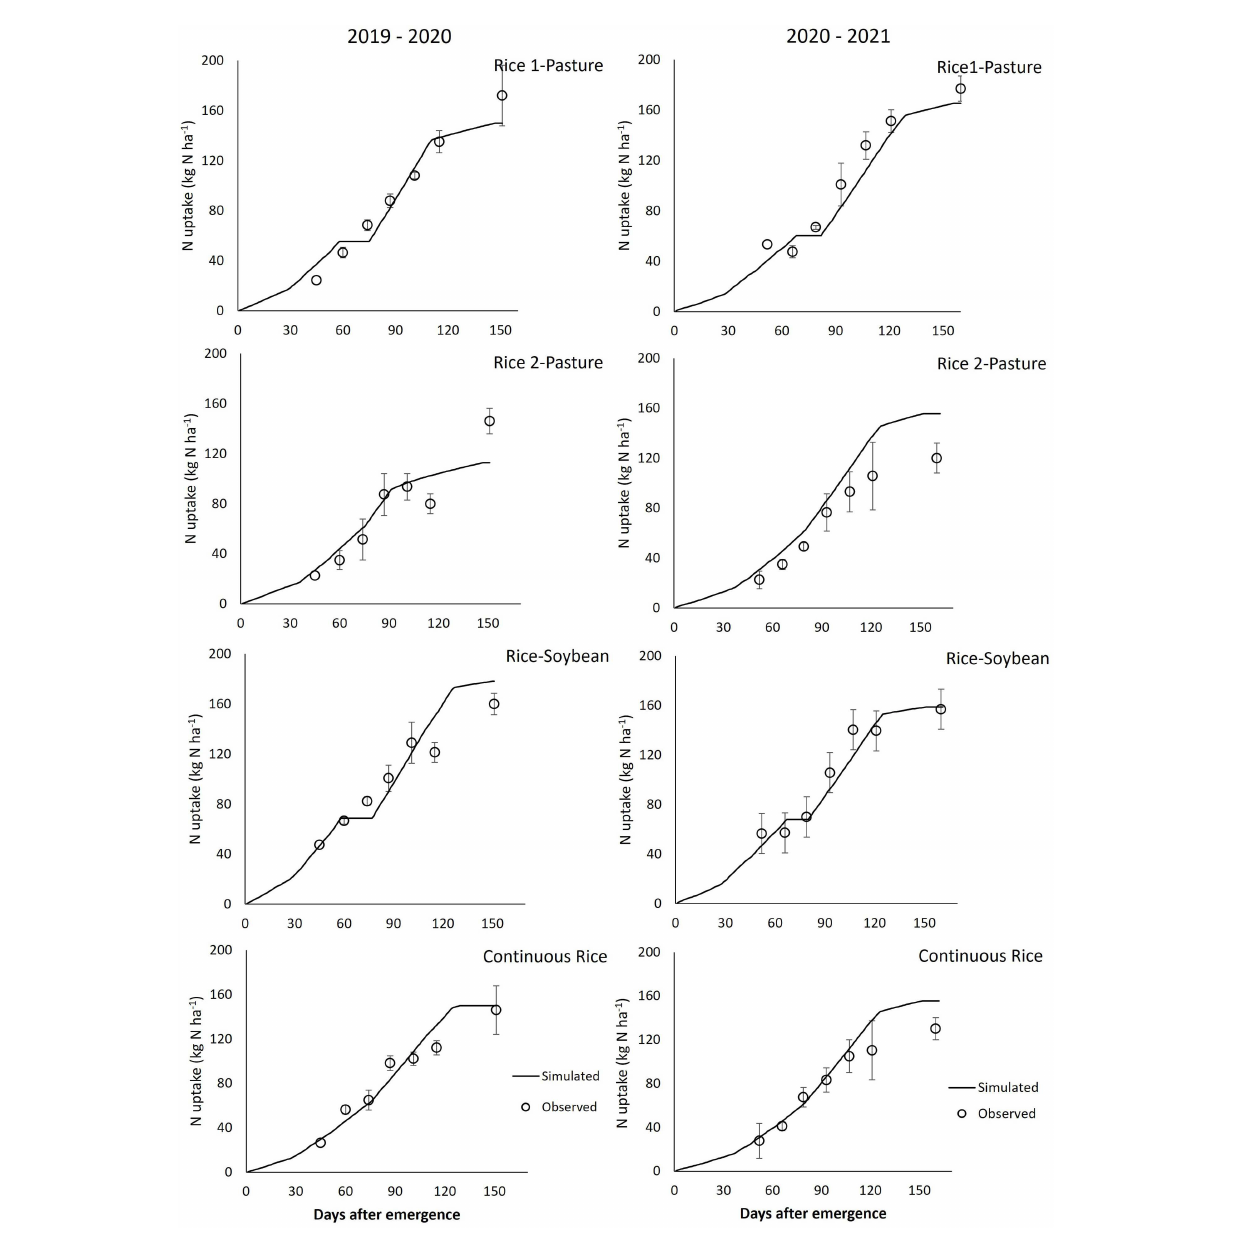
FIGURE2 Comparison of simulated and observed rice N uptake (kg N ha − 1 ) in rice-pasture (first and second rice), rice-soybean and continuous rice in the 2019–2020 and 2020–2021 growing seasons. Observed data are means ± standard errors ( n = 3).